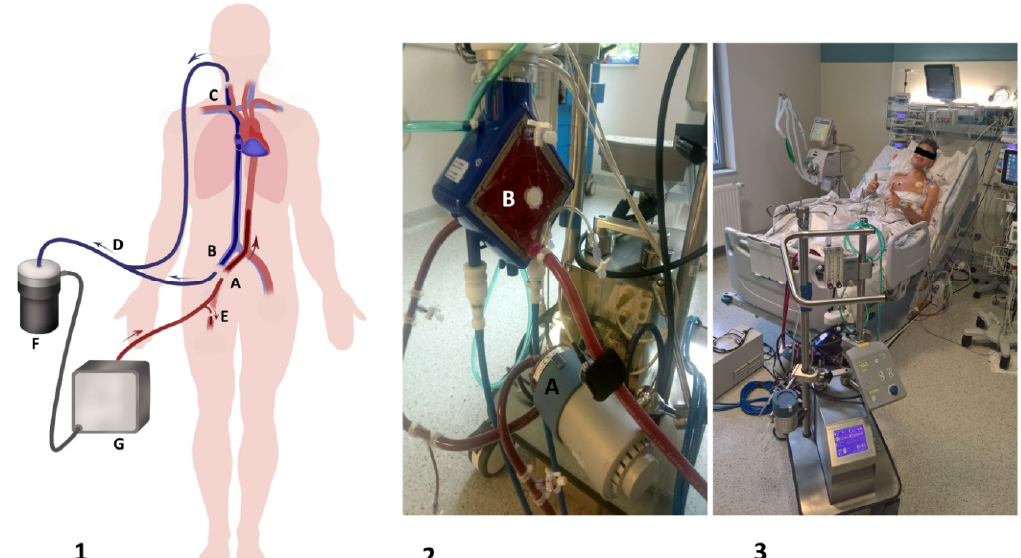
Figure 3. ( 1 ) Scheme of the veno-arterial extracorporeal membrane oxygenation circuit. (1-A) An inflow cannula is inserted through the femoral artery. (1-B) An outflow cannula is inserted through the femoral vein. (1-C) An outflow cannula is inserted through the right internal jugular vein. (1-D) The common outflow cannula, comprising (1-B) and (1-C), is merged with a Y-shaped connector. (1-E) The peripheral leg perfusion cannula. (1-F) The centrifugal pump. (1-G) The oxygenator. ( 2 ) Close-up of the pump (2-A) and oxygenator (2-B). ( 3 ) An awake, extubated patient after double lung transplantation due to idiopathic pulmonary arterial hypertension (authors’ own material).